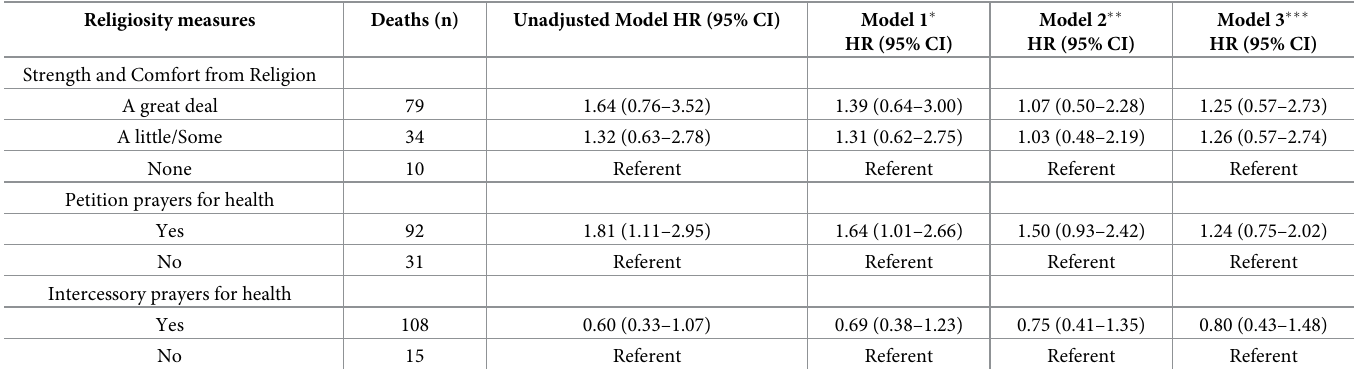
Note: The unadjusted model includes all three measures of religiosity � Model 1: Adjusted for sociodemographic variables: age, sex, and race/ethnicity �� Model 2: Adjusted for the sociodemographic variables in Model 1, and clinical variables: type of acute coronary syndrome, receipt of reperfusion therapy, length of index hospitalization, comorbidities at admission, GRACE risk score ��� Model 3: Adjusted for the sociodemographic and clinic variables in Model 2, and psychosocial variables: symptoms of depression and physical component of SF-36 Quality of Life